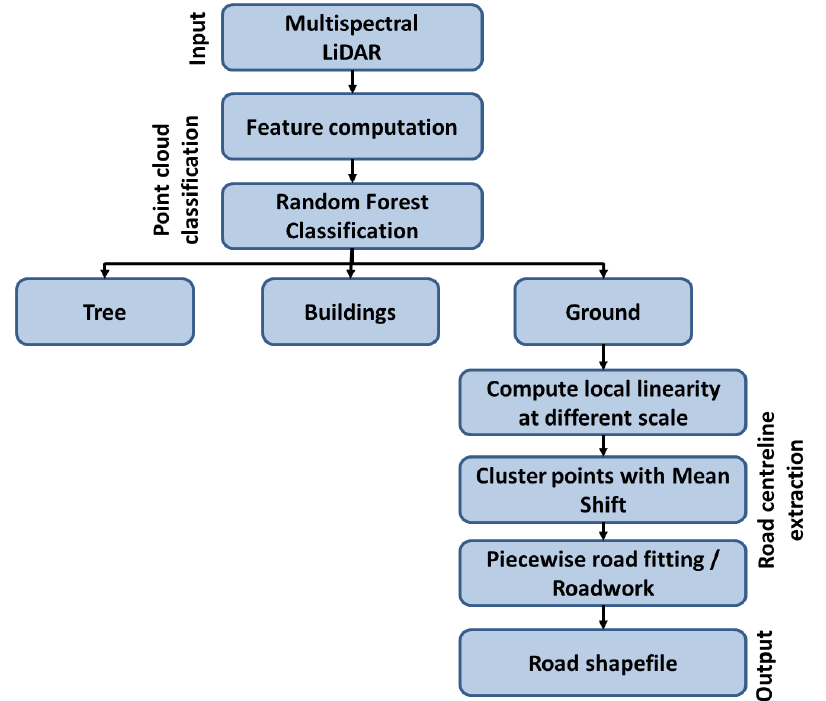
Figure 5. Schematic workflow of the proposed method for automatic extraction of road centerline form LiDAR data.